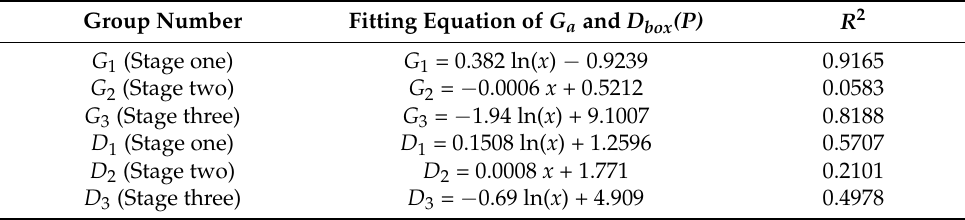
Table 3. Fitting results of G a and D box (P) with related R 2 for three stages.